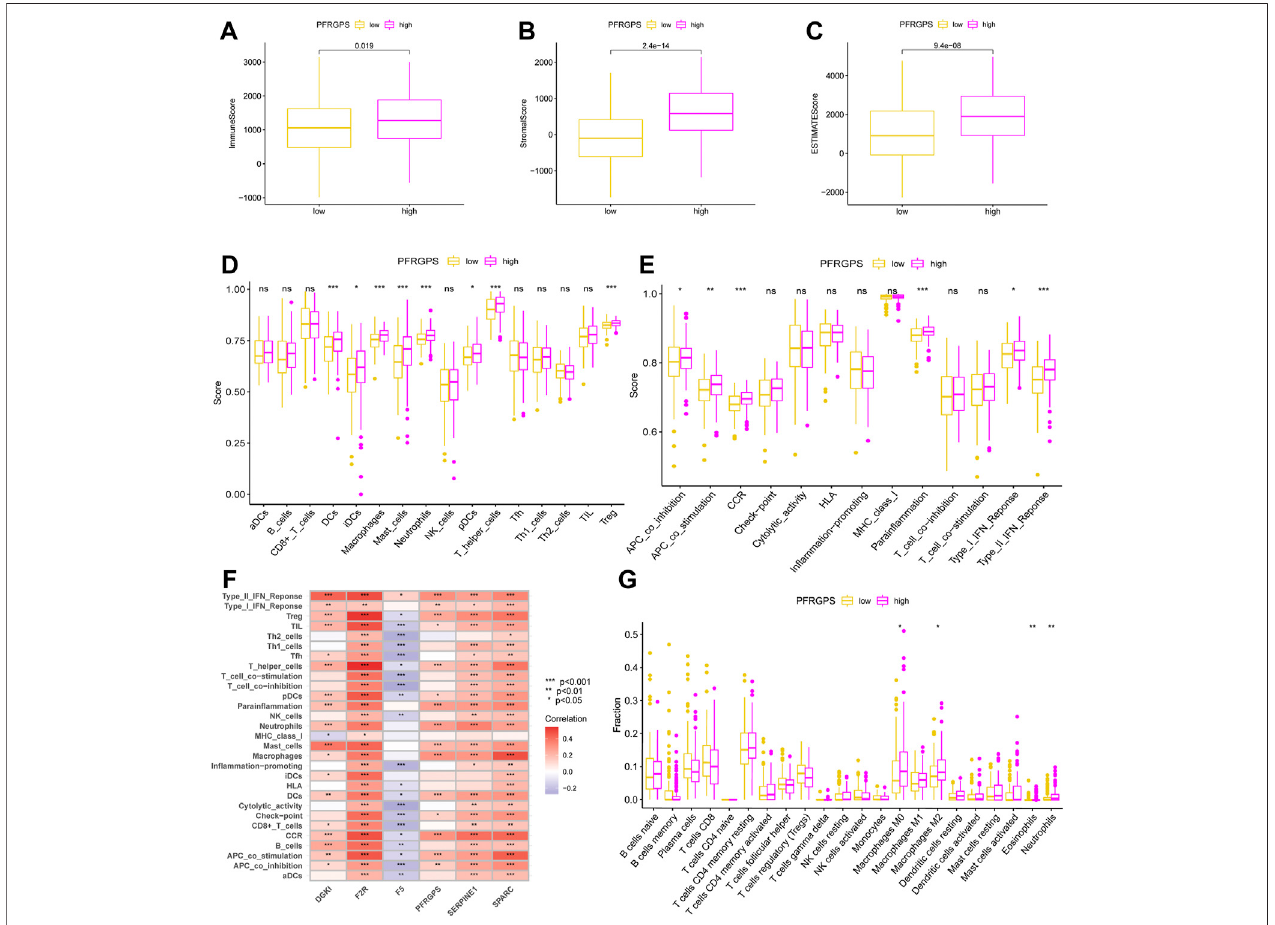
FIGURE 7 | Analysis of tumor microenvironment in TCGA cohort. (A) The boxplot of ImmuneScore differences in the low-PFRGPS and high-PFRGPS subgroups. (B) TheboxplotofStromalScore differences inthelow-PFRGPSandhigh-PFRGPS subgroups. (C) TheboxplotofESTIMATEScoredifferences inthelow-PFRGPSand high-PFRGPS subgroups. (D) The boxplot of 16 immune cell differences in the low-PFRGPS and high-PFRGPS subgroups. (E) The boxplot of 13 immune signaling pathway differences in the low-PFRGPS and high-PFRGPS subgroups. (F) Correlation analysis of PFRGPS and fi ve PPFGs with immune cells and signaling pathways. (G) The boxplot of 22 immune cell in fi ltration differences between high- and low-PFRGPS subgroups. PFRGPS, platelet function-related genes prognostic score; PPFGs, prognosis-related platelet.